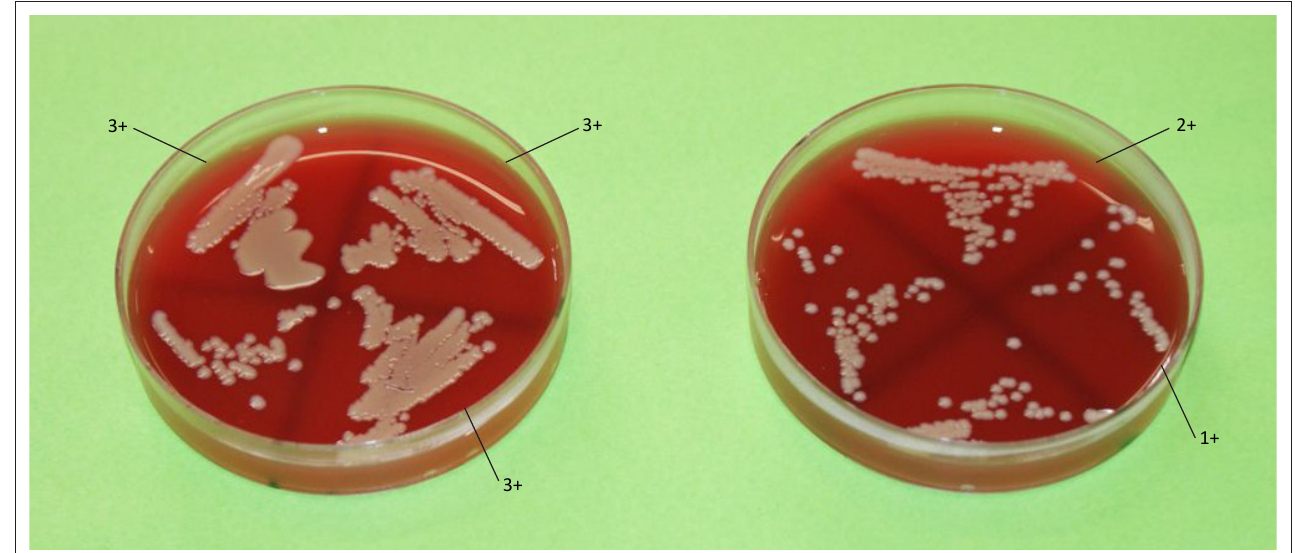
FIGURE 2: Columbia Agar base plates showing growth